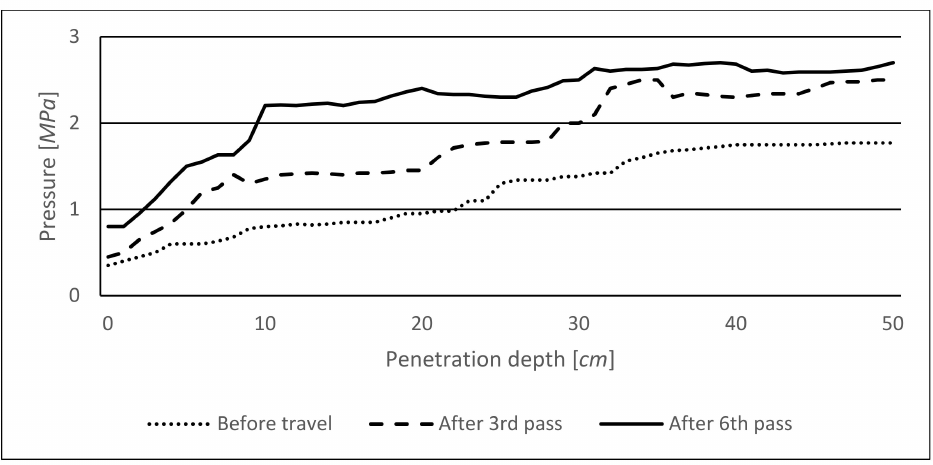
Figure 8. Soil profile compaction before travel, and after the third and sixth pass of the loaded wheeled